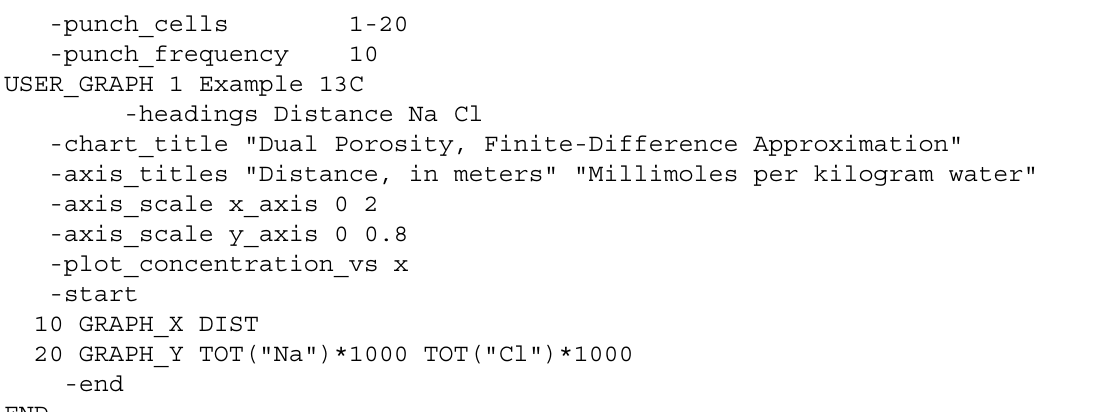
Table 35. Input file for example 13C: Stagnant zone with diffusion calculated by finite differences (partial listing).—Continued